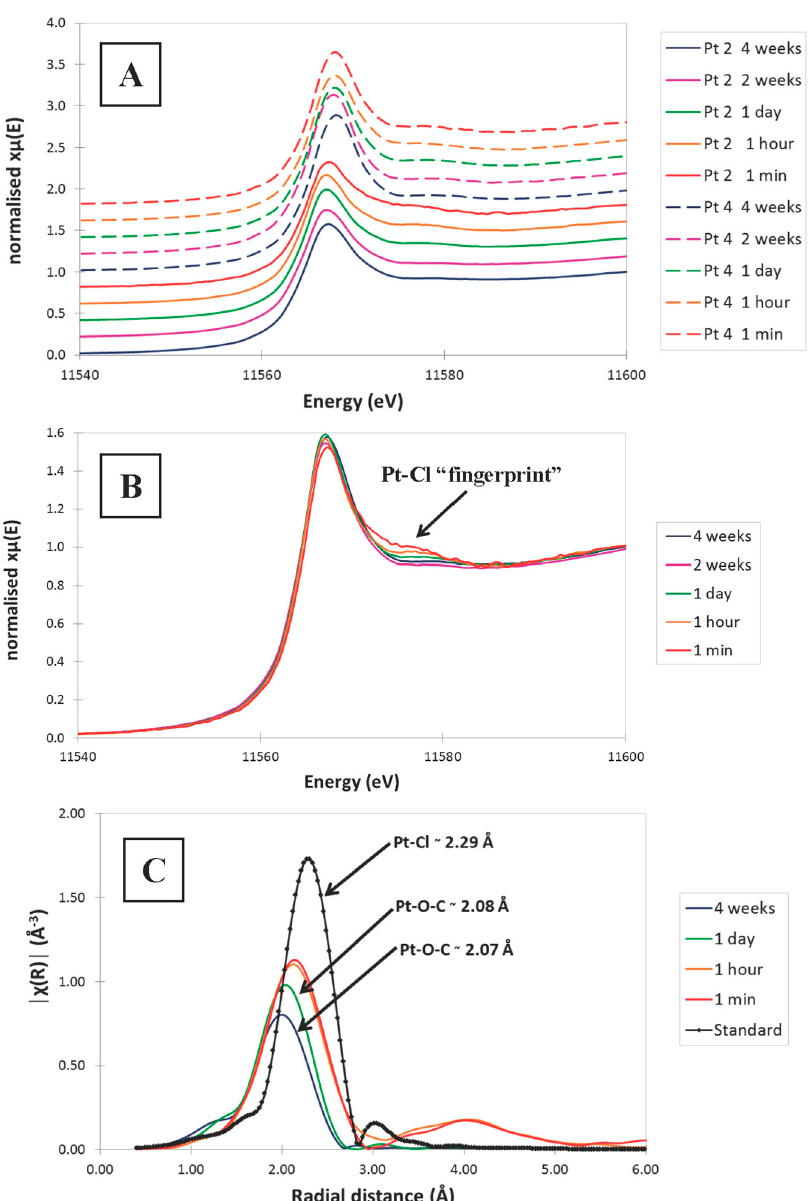
Figure 7. ( A ) XANES spectra of bacteria reacted with 5000 µ M Pt(II) and Pt(IV) solutions for up to 28 days. Note that the edge peaks of Pt(IV) are slightly higher in energy than the Pt(II) peaks due to the higher oxidation state. There is no downward shift in peak energy for either the Pt(II) or Pt(IV) over the 28 days, indicating that synchrotron energy did not detect any reduction of platinum; ( B ) XANES and EXAFS spectra of bacteria reacted with 5000 µ M Pt(II) solutions for up to 28 days. The arrow notes the Pt-Cl “fingerprint”, which decreases over time. There is no downward shift in peak energy for Pt(II) over the 28 days, indicating that synchrotron energy did not detect any reduction of platinum; ( C ) EXAFS spectra of bacteria reacted with 5000 µ M Pt(II) solutions for up to 28 days. The solid arrows show the first shell-binding partners of Pt. Note that Pt-Cl bonding shifts to Pt-O-C over time.